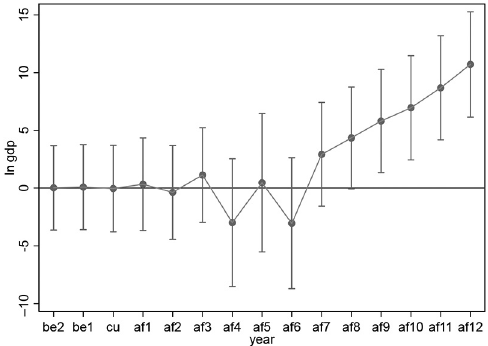
Figure 3. Dynamic effect of the policy